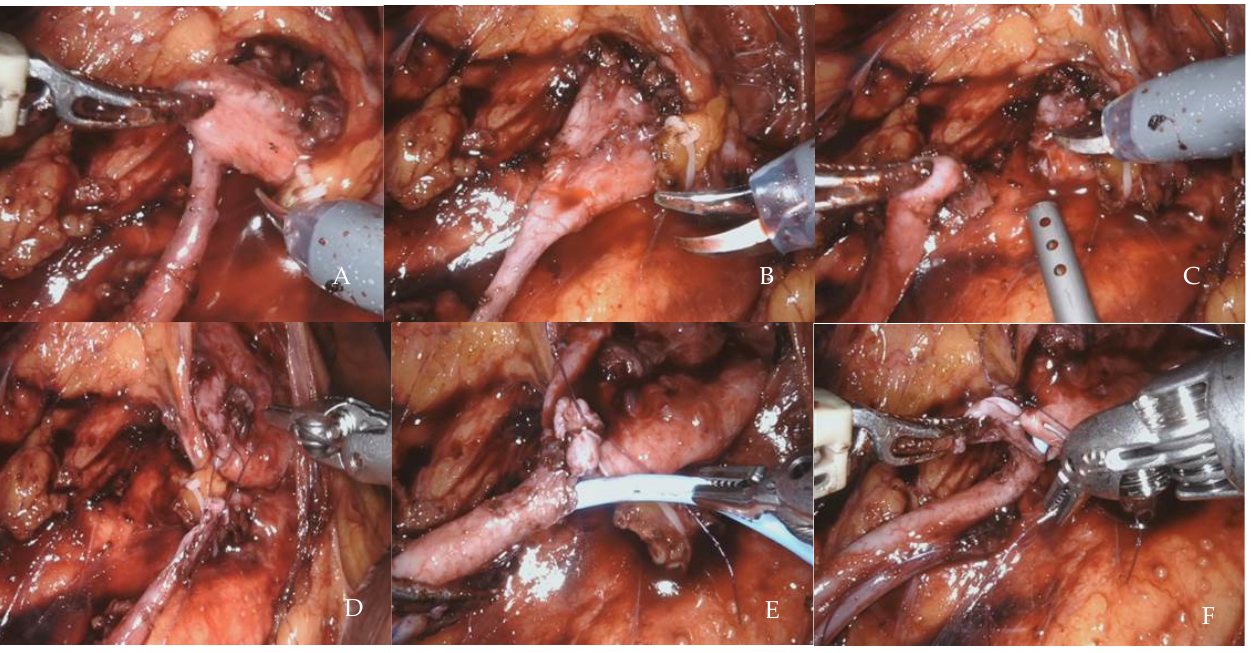
Figure 2. Robot-assisted laparoscopic pyeloplasty: main surgical steps. ( A ) Ureter traced proxi- mally till pelvis. ( B ) Ureteropelvic junction delineated and tractioned. ( C ) Pelvis dismembered. ( D ) First stitch after lateral spatulation of the ureter. ( E ) Antegrade stenting after posterior suture was completed. ( F ) Anterior